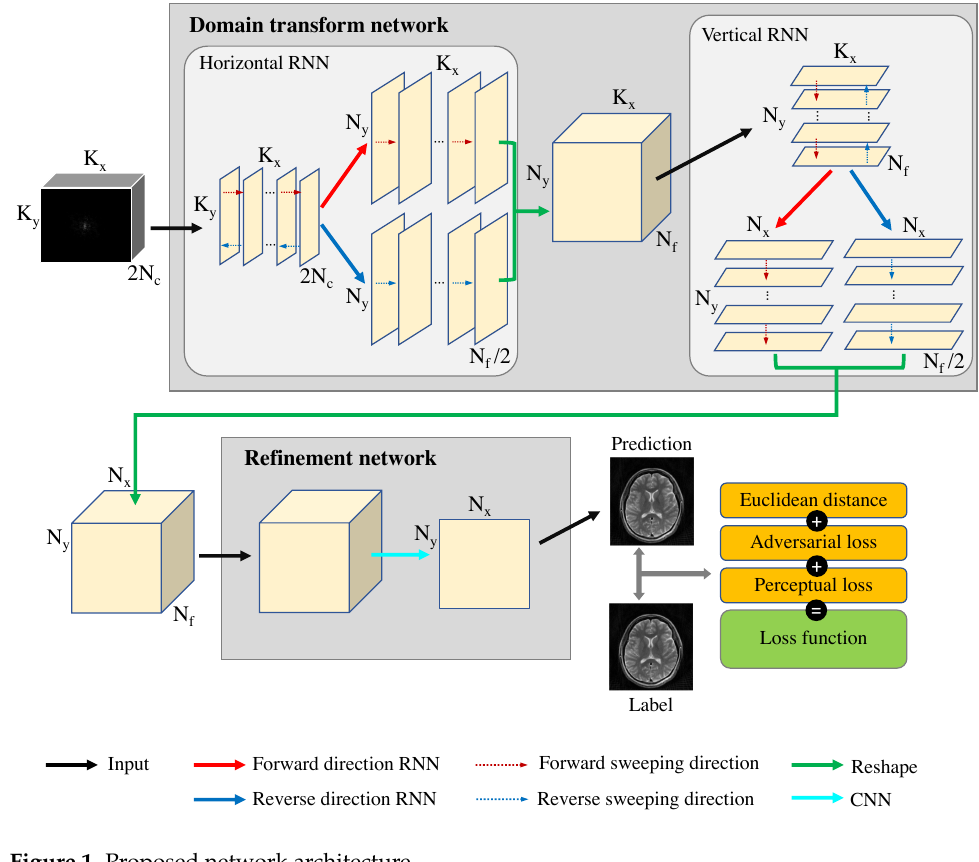
Figure 1. Proposed network